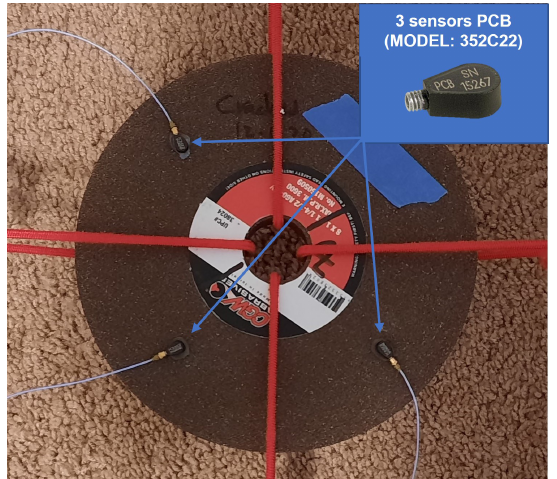
Figure 5. Measurement setup for impact hammer